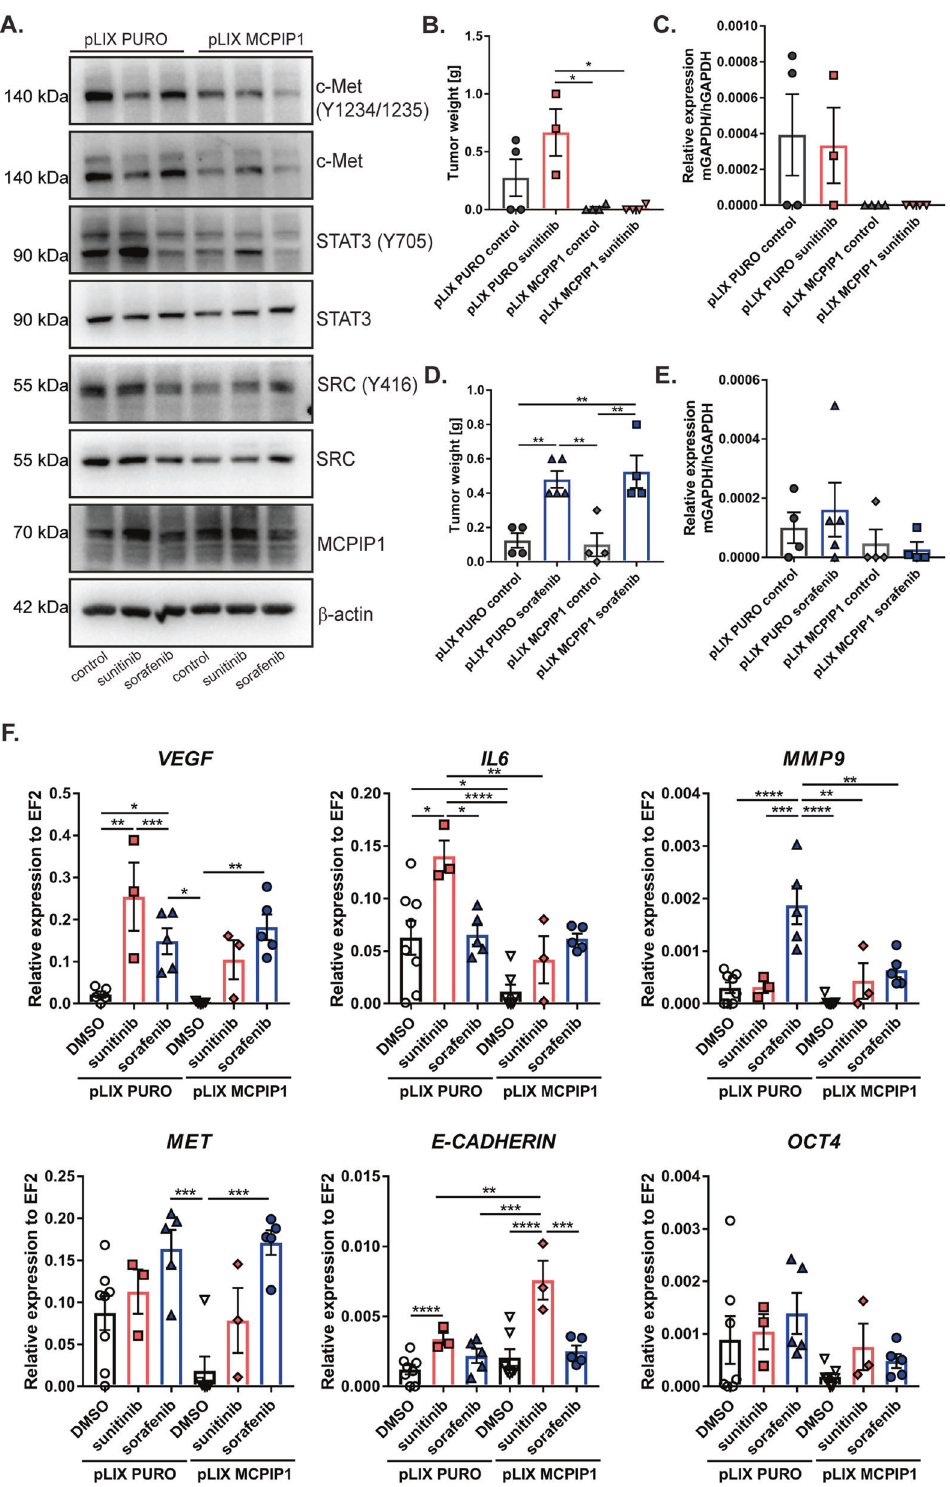
Fig. 7 MCPIP1 in overcoming drug resistance. A Western blot of MCPIP1-overexpressing Caki-1 cells after 24 h treatment with drugs; β -actin was used as a loading control. B Effect of sunitinib resistance and MCPIP1 overexpression on tumor weight. C mRNA analysis of lung metastasis using real-time PCR. The results are presented as the mean ± SEM. N = 4 for each group except pLIX-PURO-sunitinib, where N = 3. D Effect of sorafenib resistance and MCPIP1 overexpression on tumor weight. E mRNA analysis of lung metastasis using real-time PCR. The results are presented as the mean ± SEM. pLIX-PURO-control, N = 4; pLIX-PURO-sorafenib, N = 5; pLIX-MCPIP1-control, N = 4; pLIX-MCPIP1- sorafenib, N = 4. F mRNA analysis of tumor tissue samples. The results are presented as the mean ± SEM. pLIX-PURO-control, N = 8; pLIX- PURO-sunitinib, N = 3; pLIX-PURO-sorafenib, N = 5; pLIX-MCPIP1-control, N = 8; pLIX-MCPIP1-sunitinib, N = 3; pLIX-MCPIP1-sorafenib, N = 4. In vitro experiments were performed at least three times. P values were estimated using one-way ANOVA with post hoc Tukey ’ s multiple comparison test. * P < 0.05; ** P < 0.01; *** P < 0.001; **** P < 0.0001. Cell Death and Disease (2022)